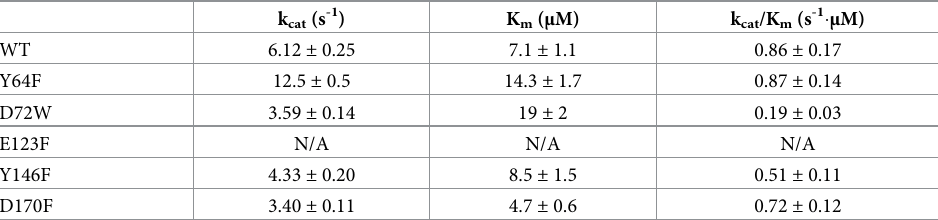
Table 3. Enzymatic assay results between AAC(3)-IIIa mutants and